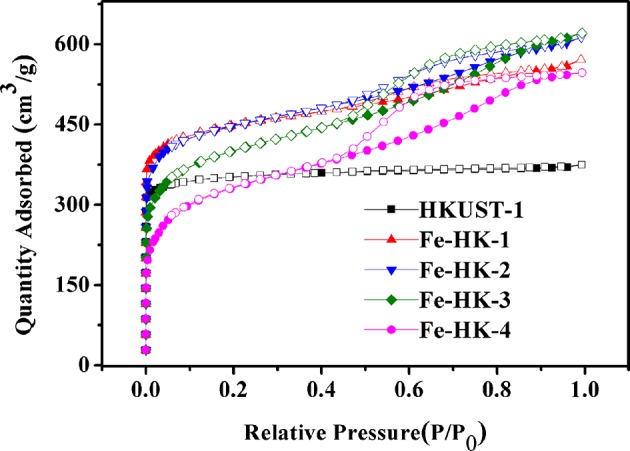
N2 isotherms of HKUST-1 and Fe-HK series samples at 77 K.